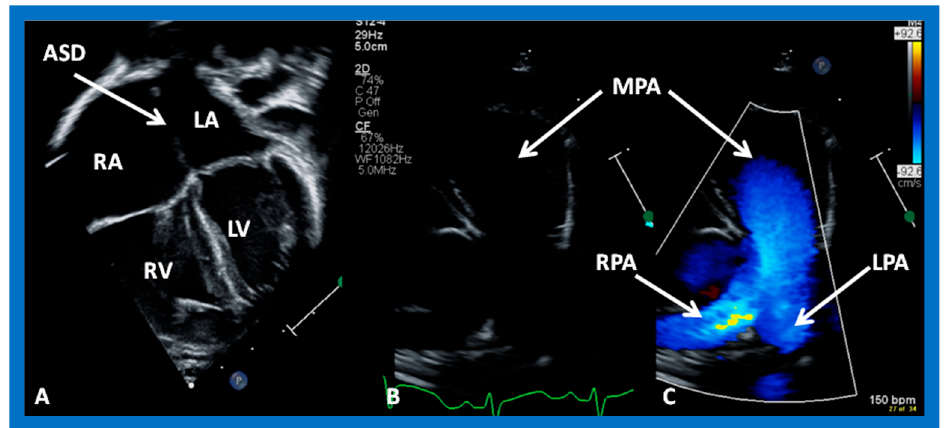
Figure 1. Echo images from apical four chamber ( A ) and precordial short axis ( B , C ) projections of a child with an atrial septal defect (ASD) demonstrating dilation of the right atrium (RA), right ventricle (RV) ( A ) and pulmonary arteries ( B , C ). LA, left atrium; LV, left ventricle; LPA, left pulmonary artery; MPA, main pulmonary artery; RPA, right pulmonary artery.